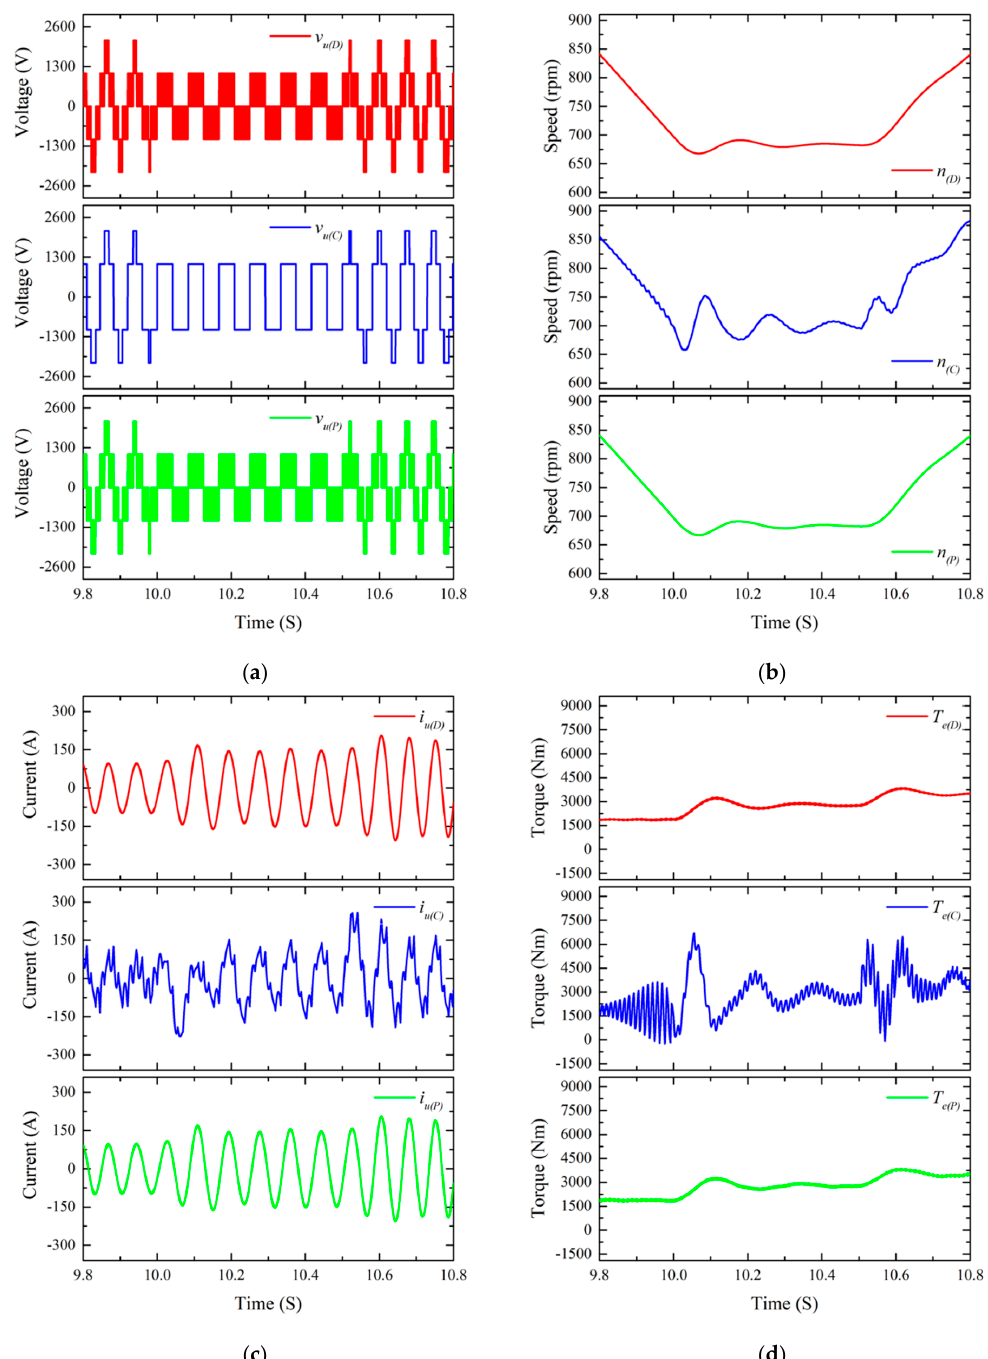
Figure 5. FFT results of phase u current at rated speed and rated load torque.